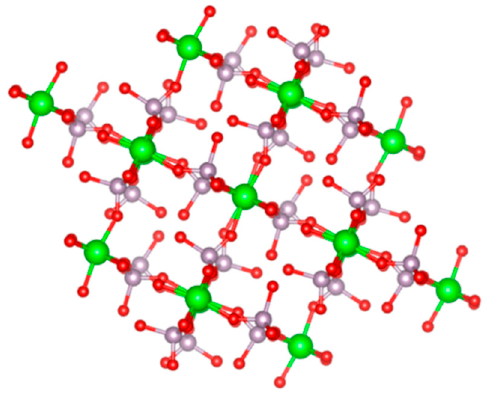
Figure 4. Ball and stick model of the structure of τ ’-ZrP [57].